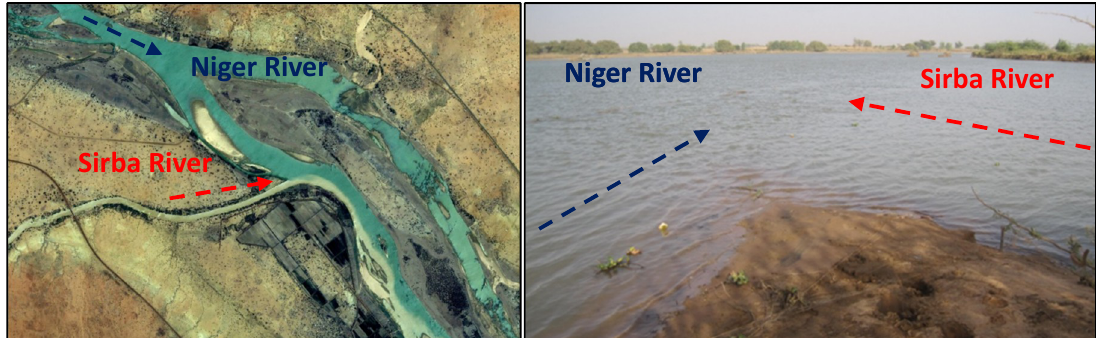
Figure 7. Left: aerial view of the Sirba-Niger confluence (source google earth [54]: 6 June 2008) with the Farié bridge. Right: photography of the confluence Sirba-Niger on 8 September 2018.